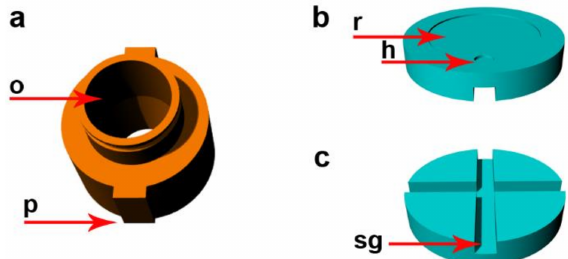
Figure 3. Description of the insert and support. ( a ) The insert. o—opening serving as a container for solvents and/or mixtures; p—protrusions complementary to the grooves in the sample part of the holder. ( b ) The upper view of the support. r—recess for accommodation of the coverslip; h—the small hole on the upper side to improve manipulation with the coverslip. ( c ) The bottom view of the support. sg—the system of grooves for the drainage of